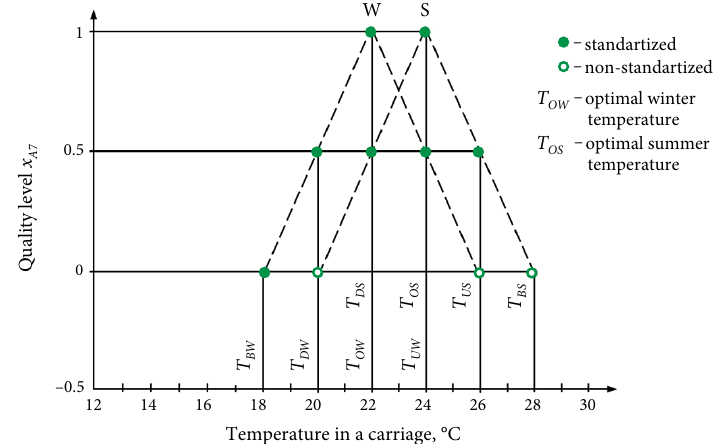
Fig. 7. The relationship between the standardized temperature in a carriage and passenger comfort in winter (when the outdoor temperature is not lower than – 40 °C) and in summer (when air conditioning is used)